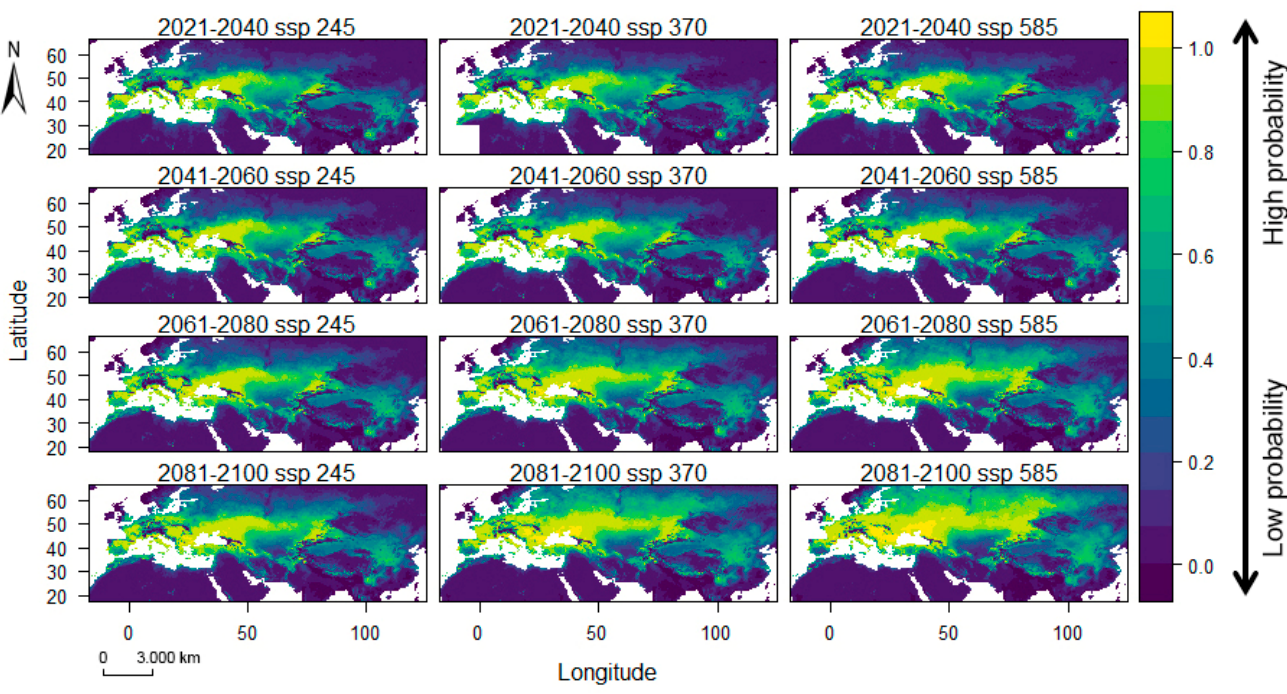
Figure 3. Average predicted climate habitat suitability maps for stranglewort ( Cynanchum acutum L.) under future climate scenarios. Average projections are presented for each of four periods (2021–2040, 2041–2060, 2061–2080, and 2081–2100) and three shared socioeconomic pathways (optimistic: SSP245; middle of the road: SSP370; and pessimistic: SSP585). The probability of occurrence ranges from 0 (dark blue, low probability) to 1 (yellow, highest probability).